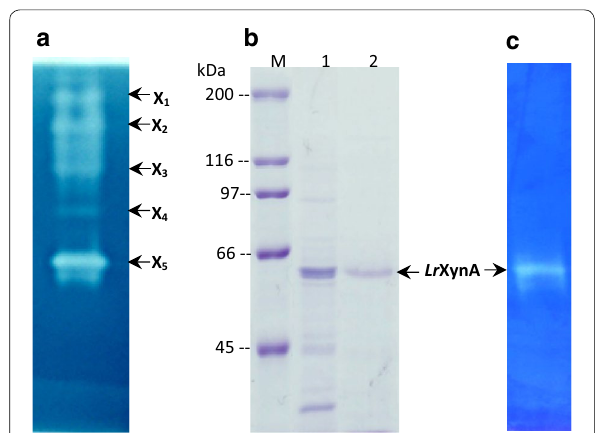
Fig. 4 Protein and zymogram analysis of Lr XynA from L. ramosa H71D on 10% SDS‑PAGE. a Zymogram analysis of crude extract from L. ramosa H71D, using 1% RBB‑X as the substrate. b 10% SDS‑PAGE analysis of purified Lr XynA. Lanes: M, molecular weight standard; 1, crude extract; 2, purified Lr XynA. c Zymogram analysis of purified Lr XynA, using 1% RBB‑X as